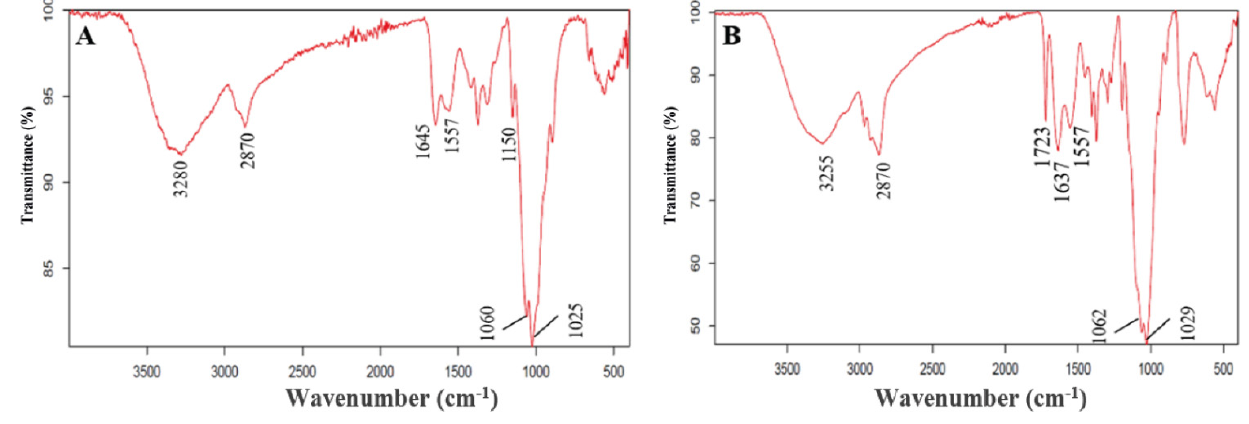
Figure 1. ATR − FT − IR spectra of ( A ) CTS and ( B ) CTS − CHO.